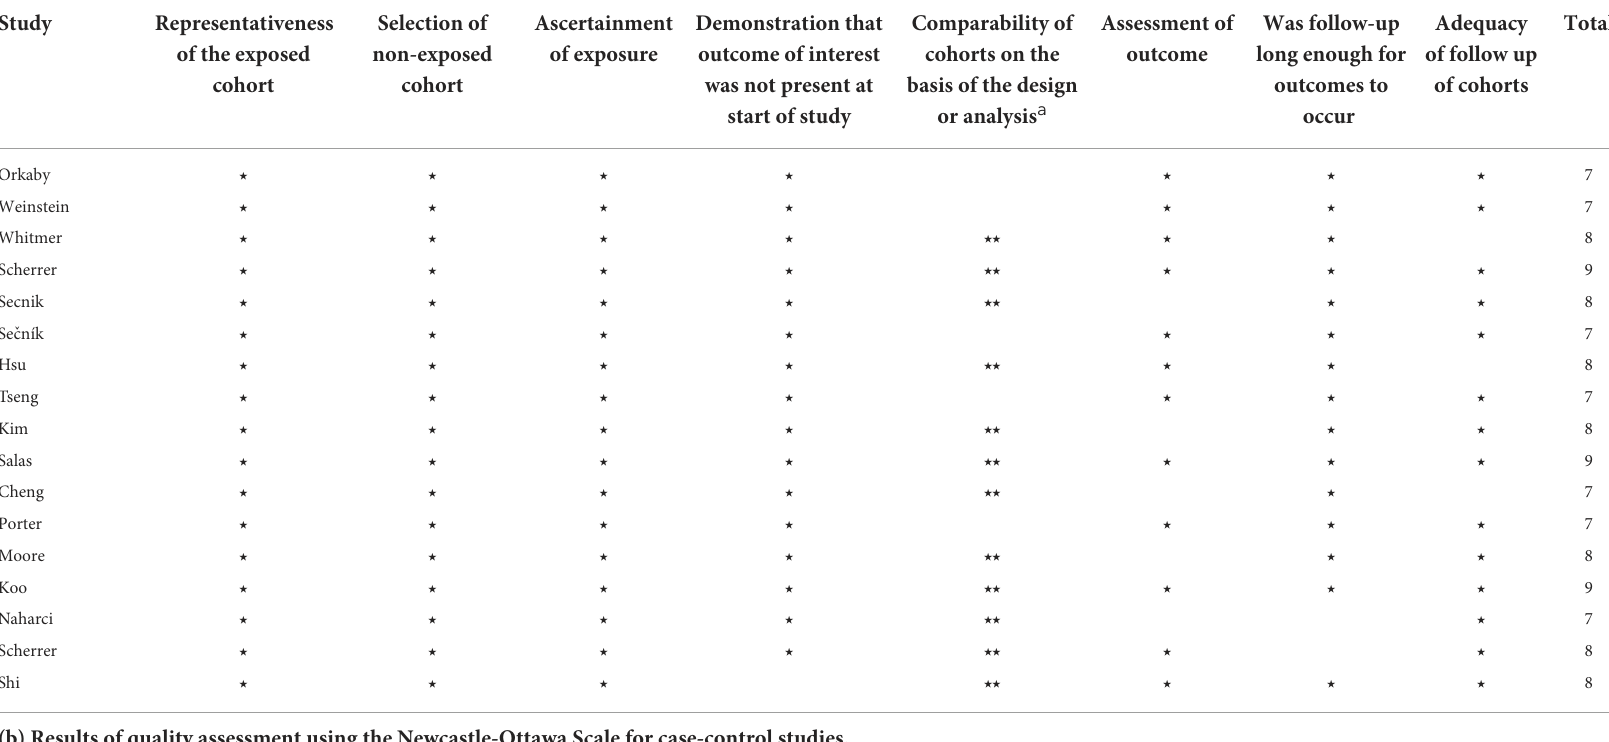
TABLE 3 Results of quality assessment of the included studies. (a) Results of quality assessment using the Newcastle-Ottawa Scale for cohort